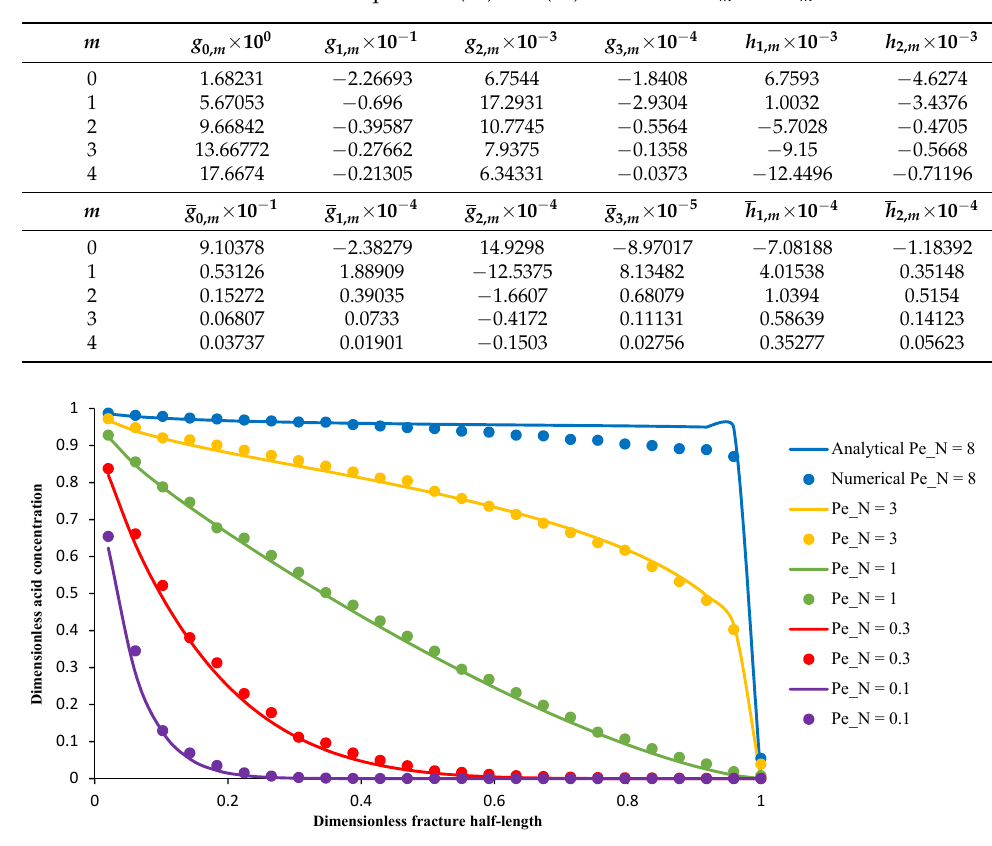
Figure 3. Comparison between the calculated acid concentration along the fracture at different Peclet numbers using the proposed model and the Terrill,1965 method [36].